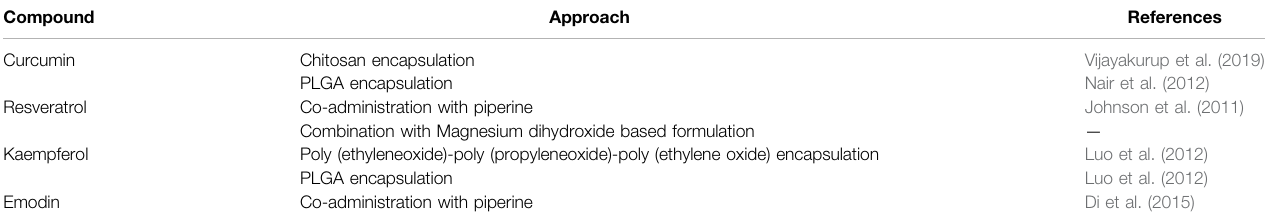
TABLE 4 | Strategic approaches aimed at improving the pharmacokinetics of prospective chemopreventives.